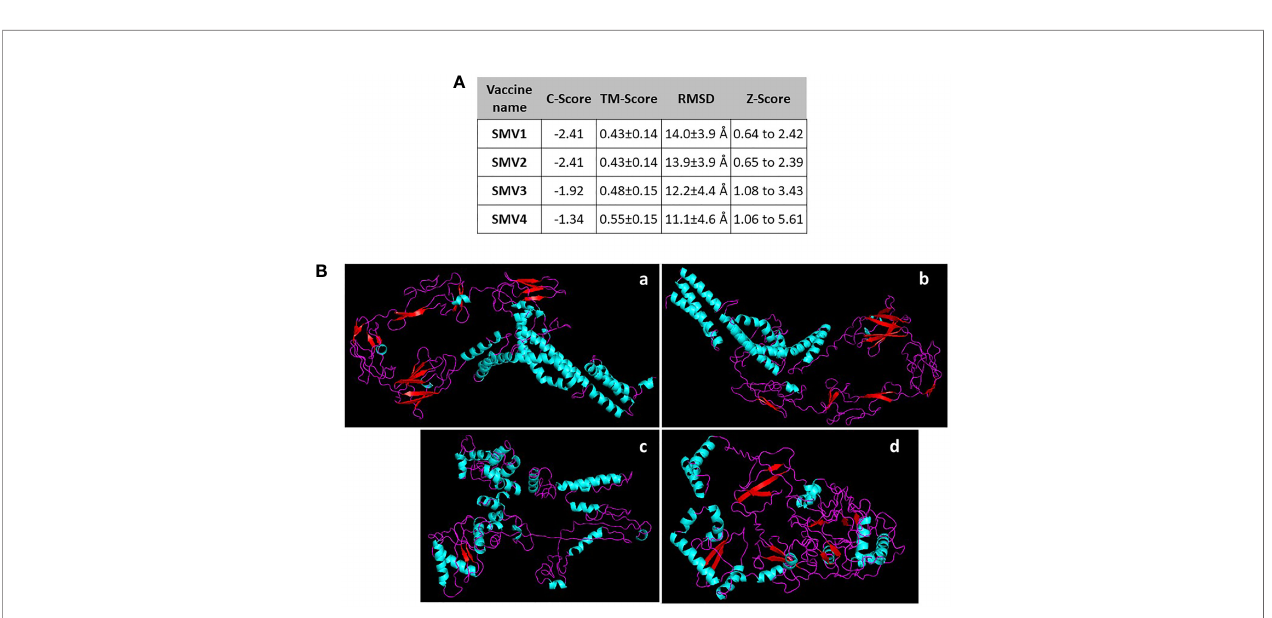
FIGURE 3 | (A) Characteristics and (B) 3D structure prediction of the constructed S. marcescens vaccines using I-TASSER server. a SMV1, b SMV2, c SMV3, d